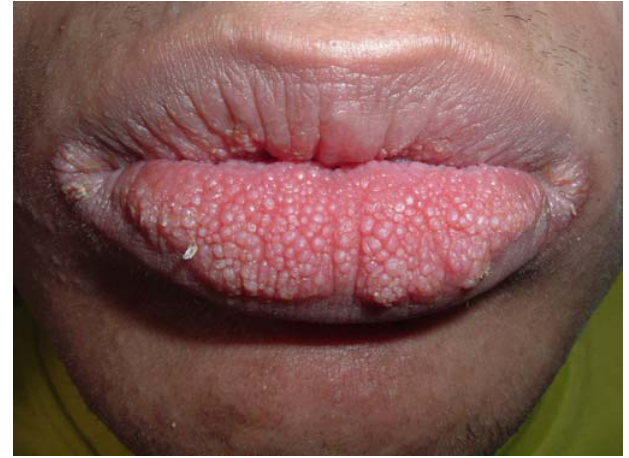
FIGURE . PCR for Human Papilloma Virus was not